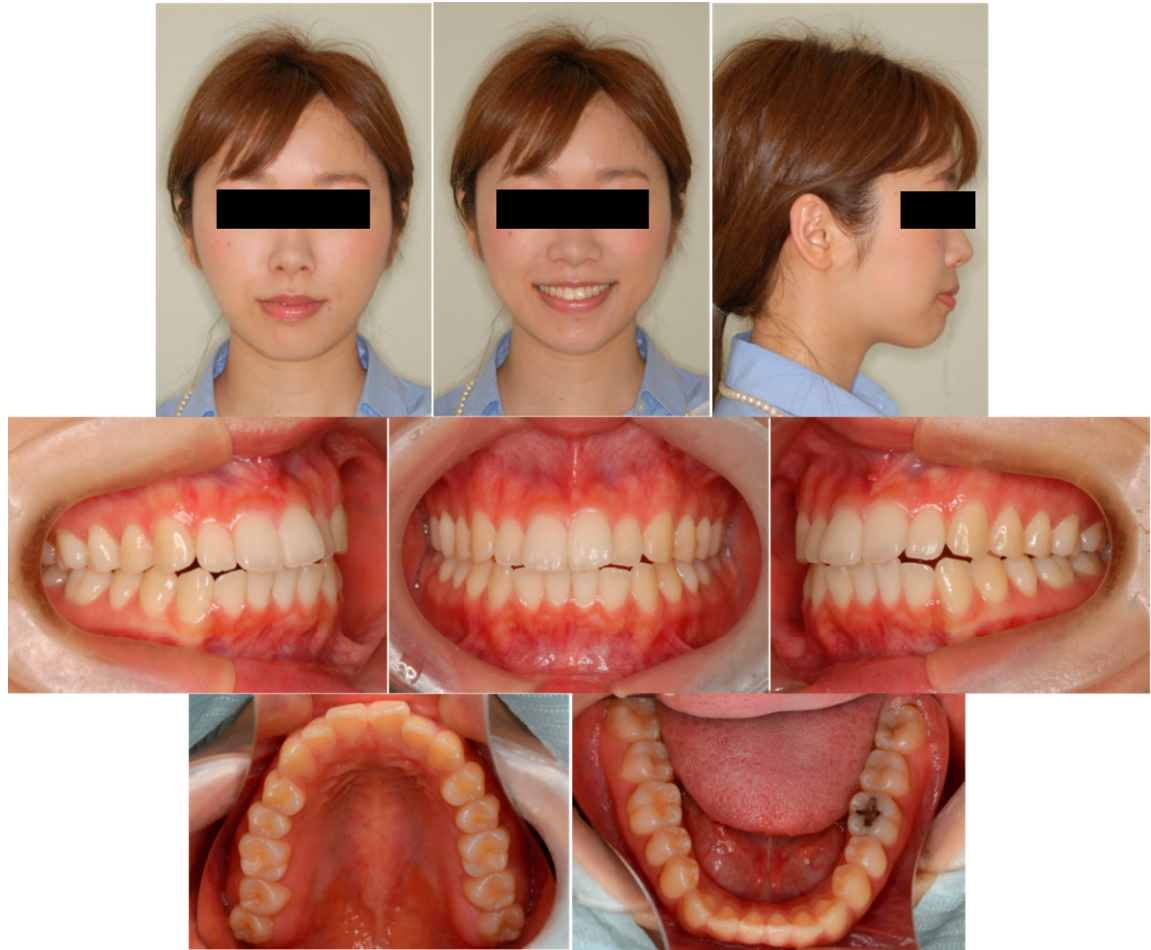
Figure 9. Pretreatment facial and intraoral photographs. (Patient is 29 years 2 months old).